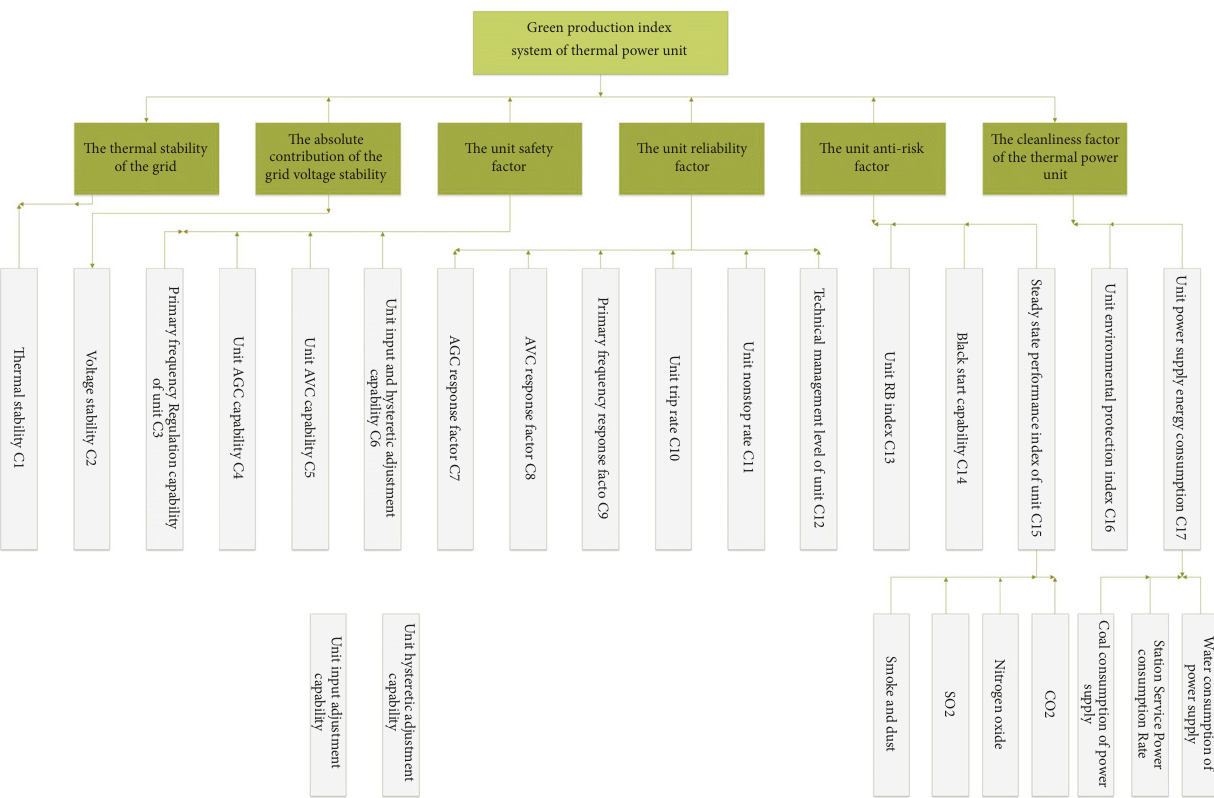
Figure 1: Green production evaluation index system of thermal power